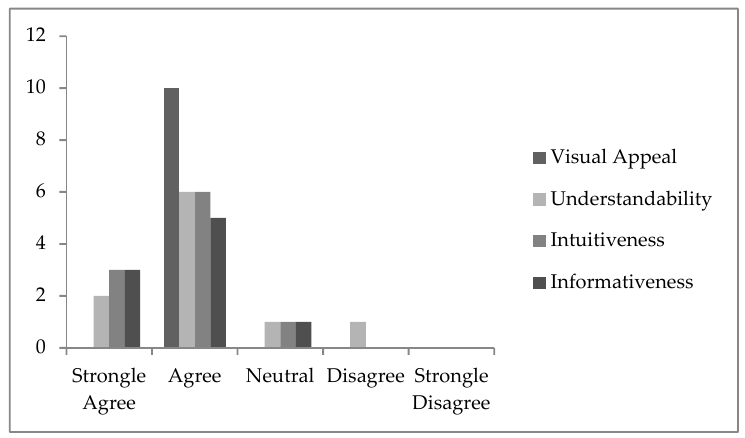
Figure 17. Result of usability study.